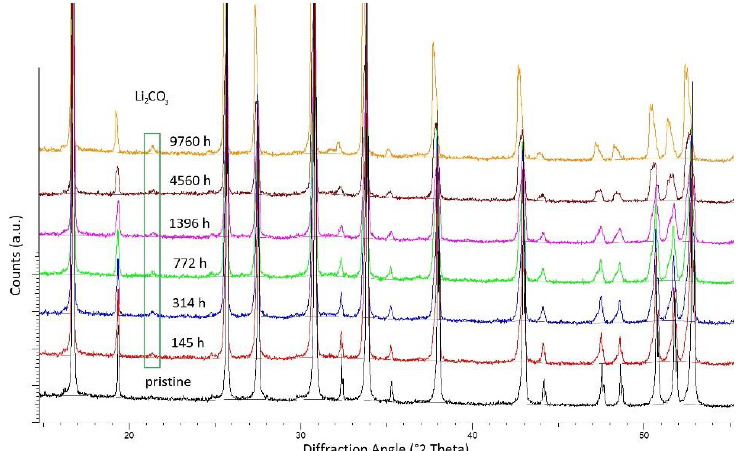
Figure 2. Sections of the powder X-ray diffraction pattern for Al20-LLZO aged in the air at different times. Note the increased amount of Li 2 CO 3 and the development of a low angle shoulder, particularly visible at higher Bragg angles.